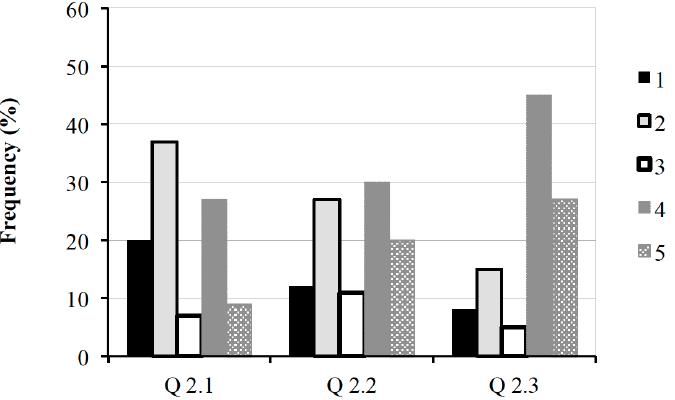
Fig. 2. Students’ responses to the questions of Section 2 in Questionnaire A presented on a five-point Likert scale, where 1 is the least